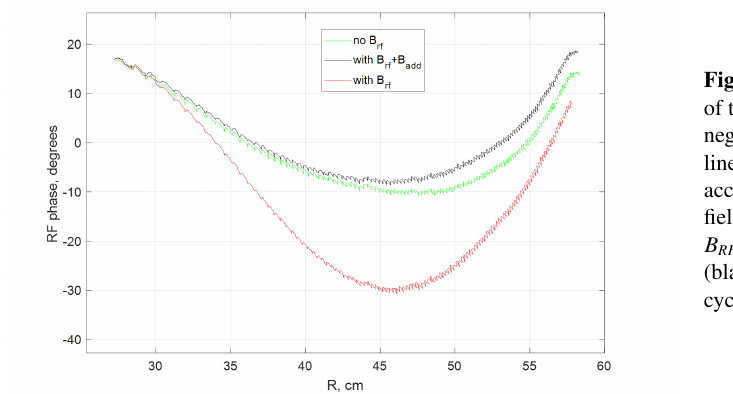
Figure 5. Phase motion of the central particle: neglecting B RF (green line), taking into account RF magnetic field (red line) and with B RF + compensation (black line) for Hefei